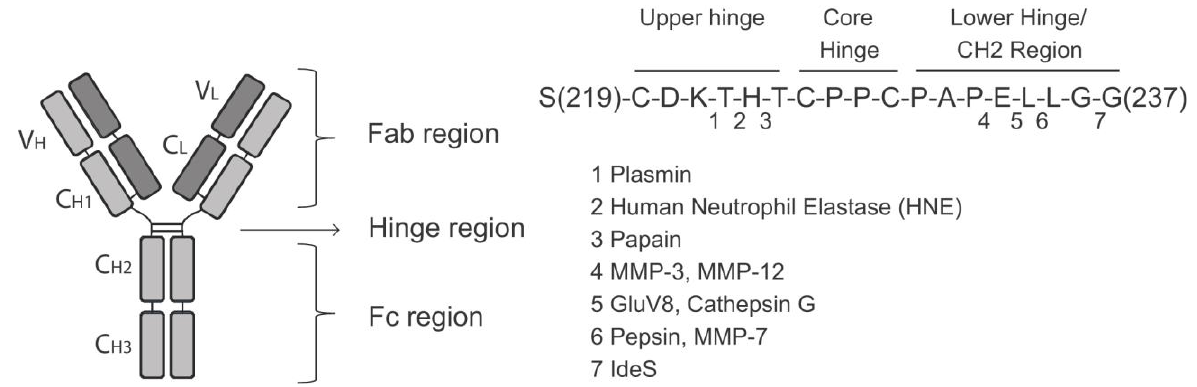
FIGURE 1. A schematic representation of a human IgG1 antibody (left side) and the amino acid sequence of the hinge region (right side). The numbers below the amino acid sequence indicate specific protease cleavage points within the hinge